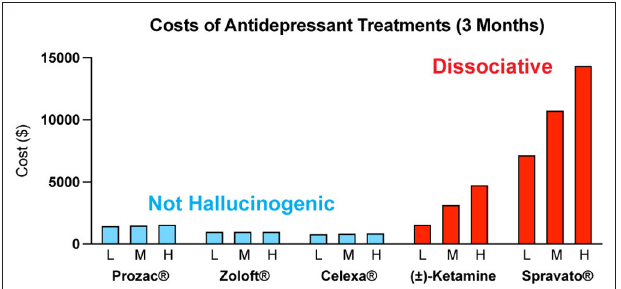
FIGURE 6 | Estimated quarterly (3 months) costs (L = low, M = medium, H = high) for daily administration of non-hallucinogenic take-home traditional antidepressants (blue) and intermittent dosing of clinically administered, dissociative psychoplastogen (ketamine) treatments (red). Note: generic ketamine costs include drug, administration (IV), and required monitoring, while Prozac ® , Zoloft ® , Celexa ® , and Spravato ® costs are for the drug only. Retail costs for SSRIs reflect the low and high branded price published on goodrx.com 2 with the medium price being calculated as an average of the two. To estimate the total cost, we used medium doses for each drug (Prozac ® 20mg, Zoloft ® 50mg, and Celexa ® 20mg,) and assumed daily dosing for 90 days. Ketamine infusion cost was sourced from ketamineclinicsdirectory.com/ketamine-infusion-cost/. 3 This site estimates the low and high cost of a complete set of 4–6 generic ketamine infusions to be $1,600–$4,800, respectively. The medium cost was calculated as an average of the two ($3,200). Our estimate for the 3-month cost of generic ketamine assumes that no additional doses are needed beyond the initial 4–6 doses. Retail Spravato ® costs were estimated based on the price of a 56mg dose ($900) published on goodrx.com 3 and dosing was based on the package insert (Revised 7/2020). The label indicates Spravato ® should be dosed twice a week during the induction phase (weeks 1–4; $900 × 2 × 4 =